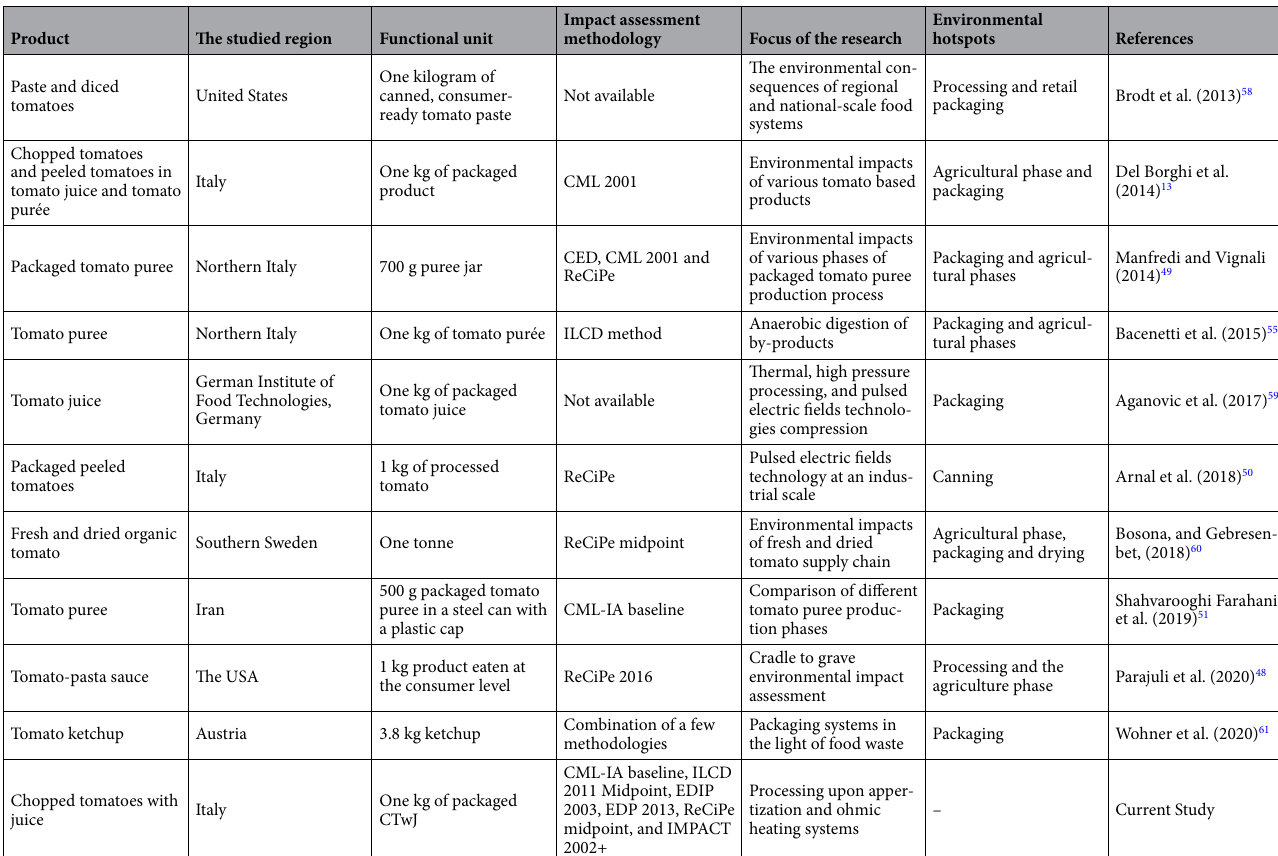
Table 1. Summary of the literature on the LCA of tomato